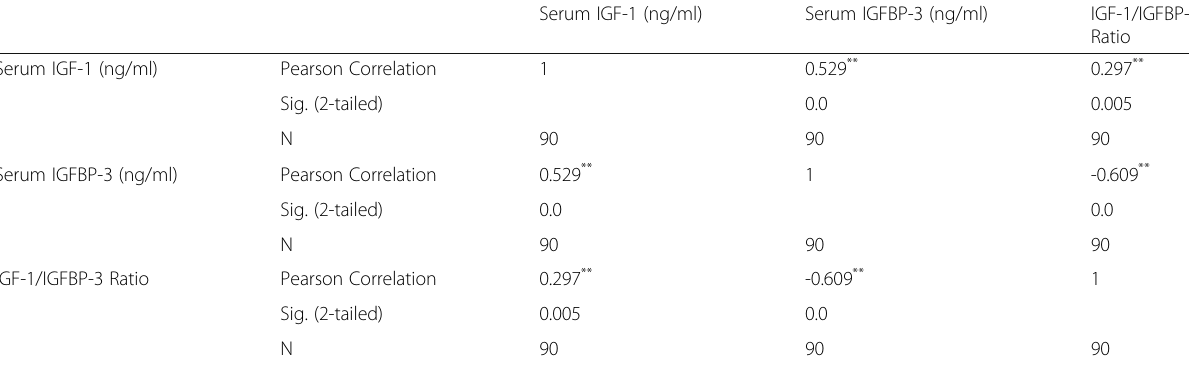
Table 5 Pearson ’ s Correlations of IGF-1, IGFBP-3 and their